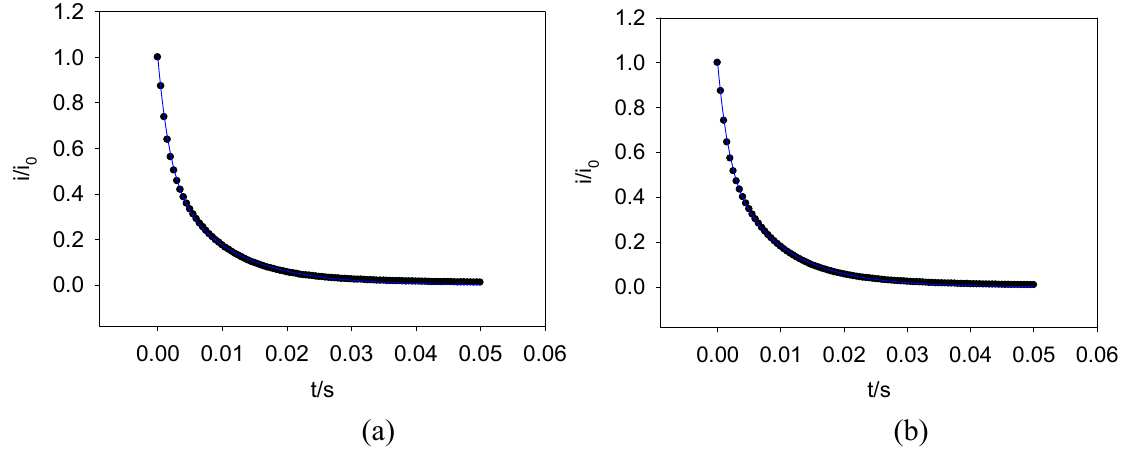
Figure 20. Potential step chronoamperometry transients recorded for (a) GOx oxidation (potential step -500 to - 300 mV ) and (b) GOx reduction (potential step from – 300 to – 500 mV) fit via SIGMAPLOT to the four parameter biexponential model. Phosphate buffer solution pH